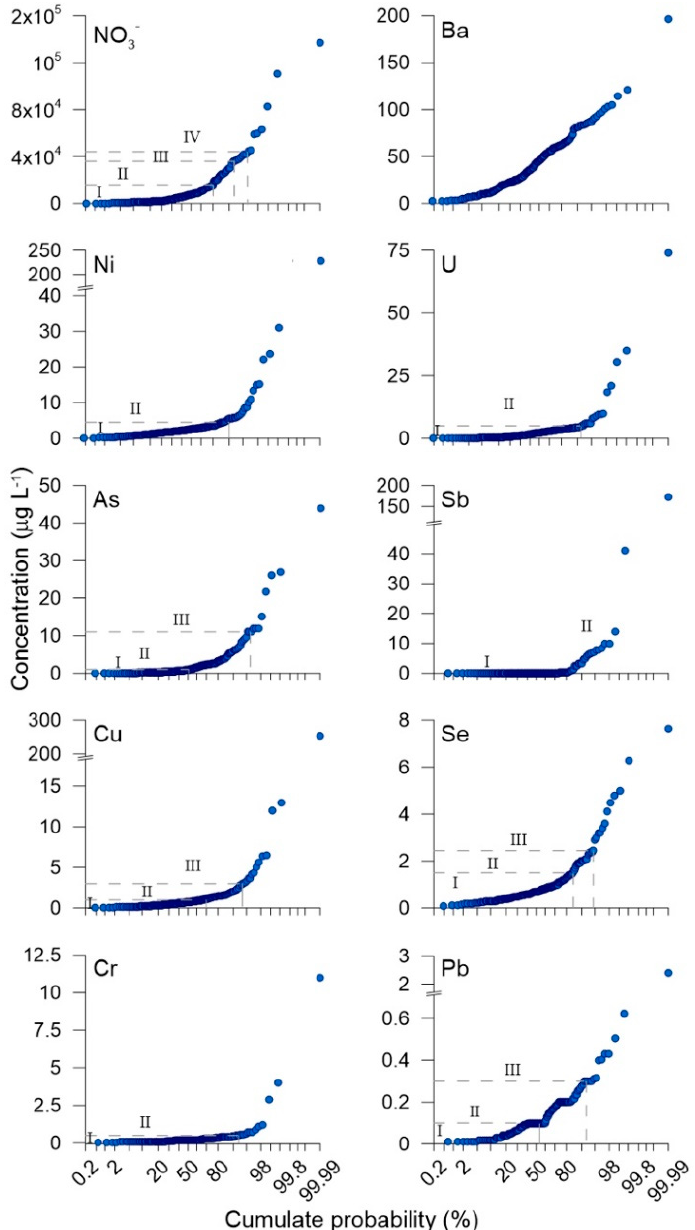
Figure 4. Probability plots of minor and trace elements (concentrations in µg L − 1 ). Roman numbers indicate the different data populations listed in Table 1. Table 1. Main identified populations with relative percentages and threshold values for selected trace elements (as µg L − 1 ).